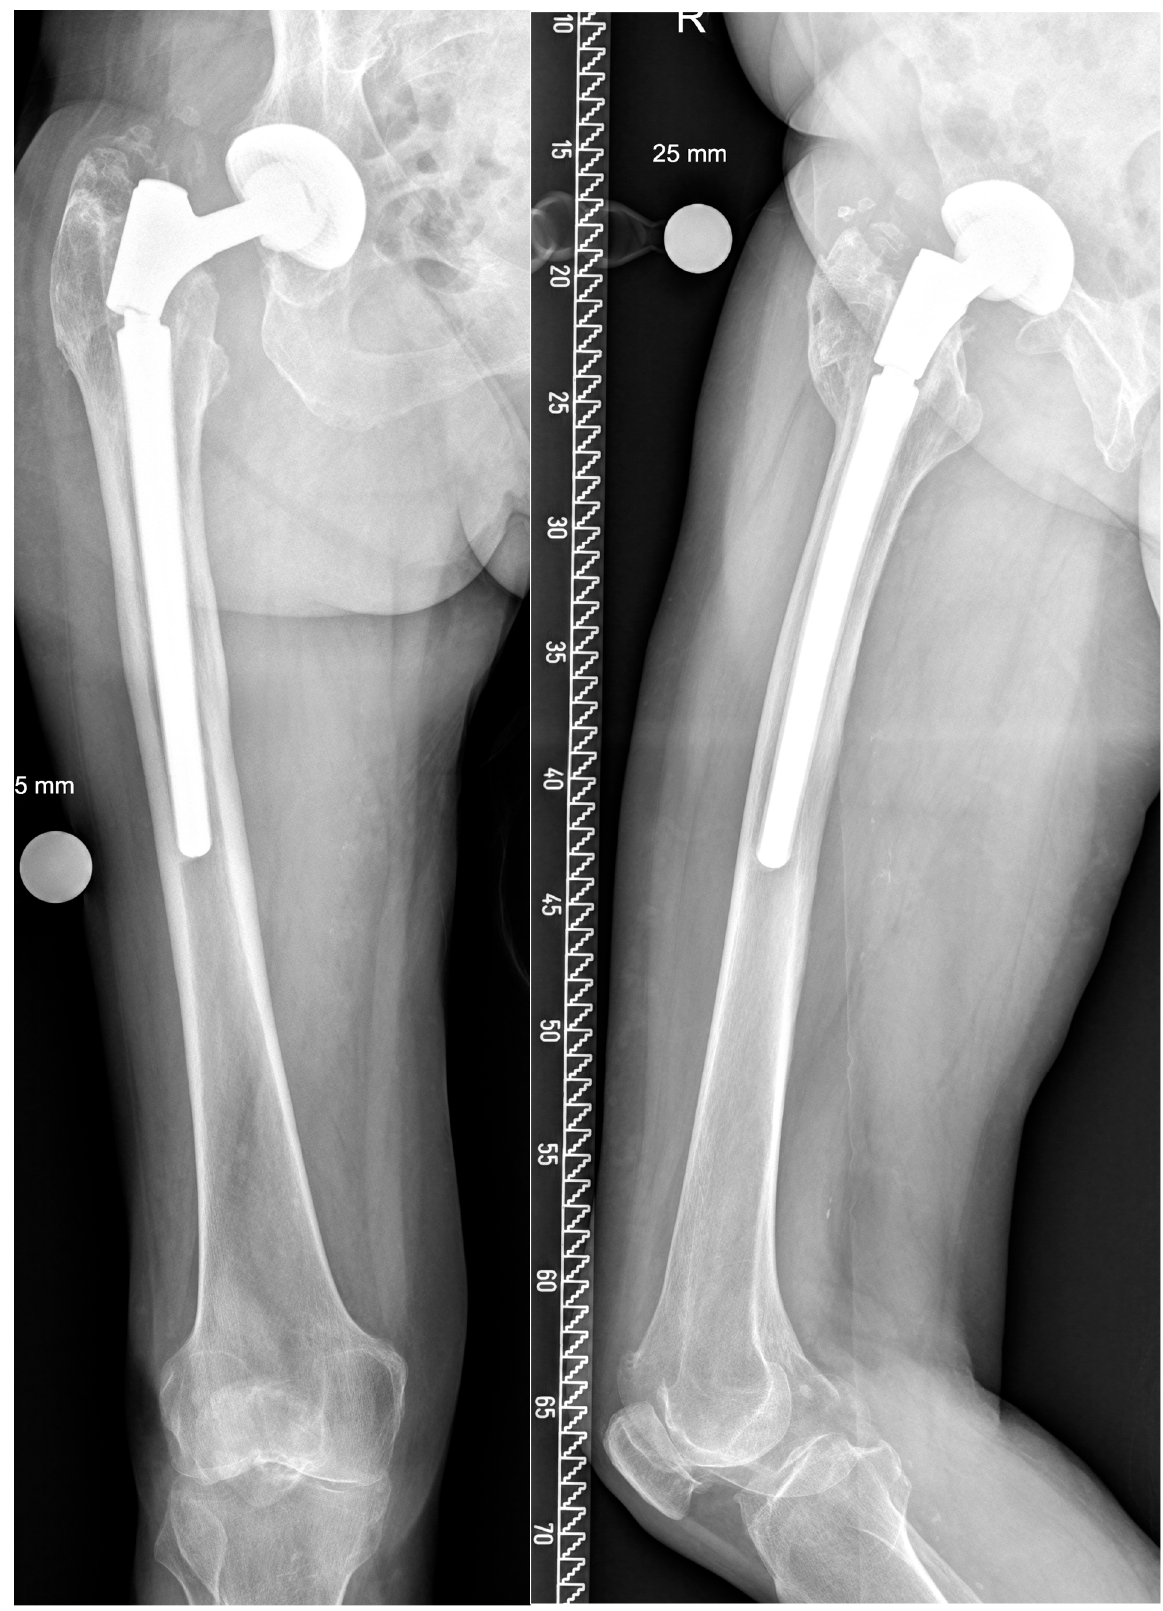
Figure 6. Patient (47 years, male) with minor bone defect and distally integrated stem until junction area.